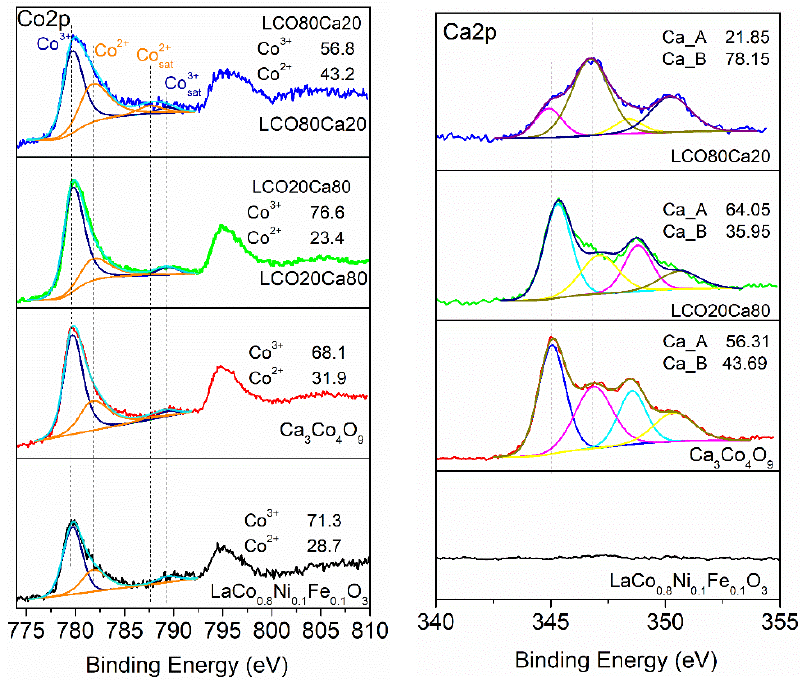
Figure 3. XPS spectra in the Co 2p ( left ) and Ca 2p ( right ) region for the perovskite and the layered oxide, as well as the composites between them.